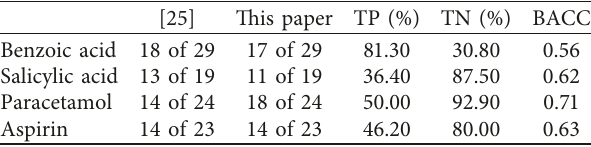
Table 5: Results of classification of API solubilities. Table 4: Results of the solubility classification of 33 polymers in 85